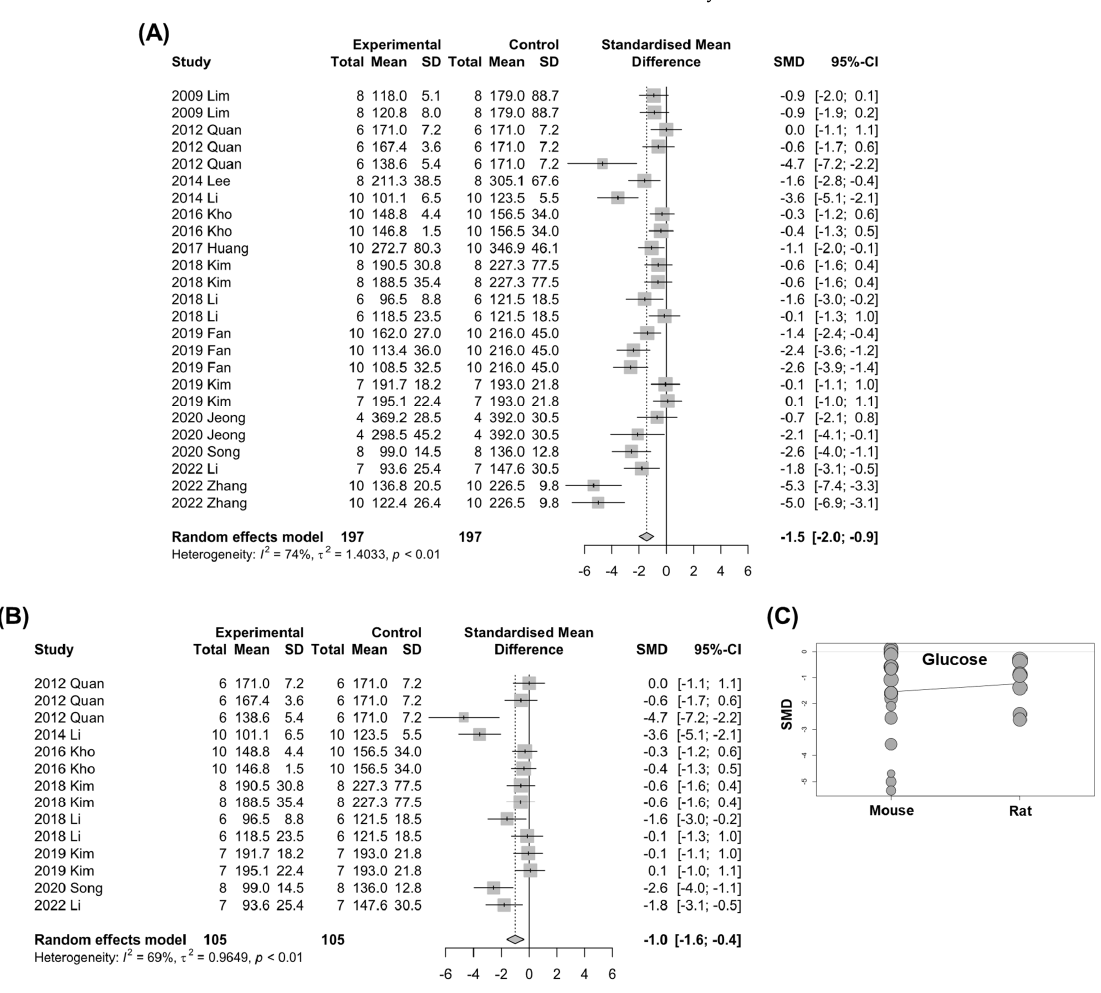
standard deviation. Each circle indicates each study.